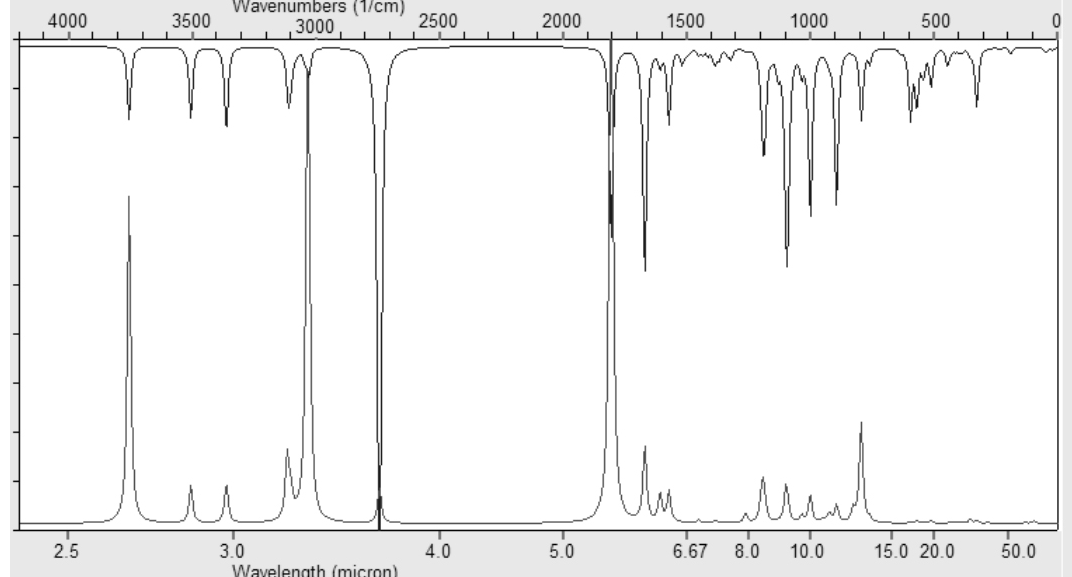
Figure 5. The thoretical vibrational spectra of investigated